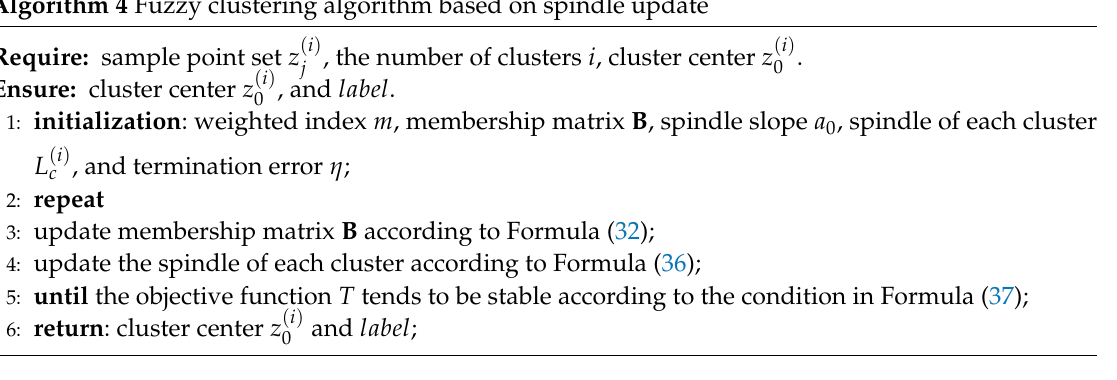
Algorithm 4 Fuzzy clustering algorithm based on spindle update